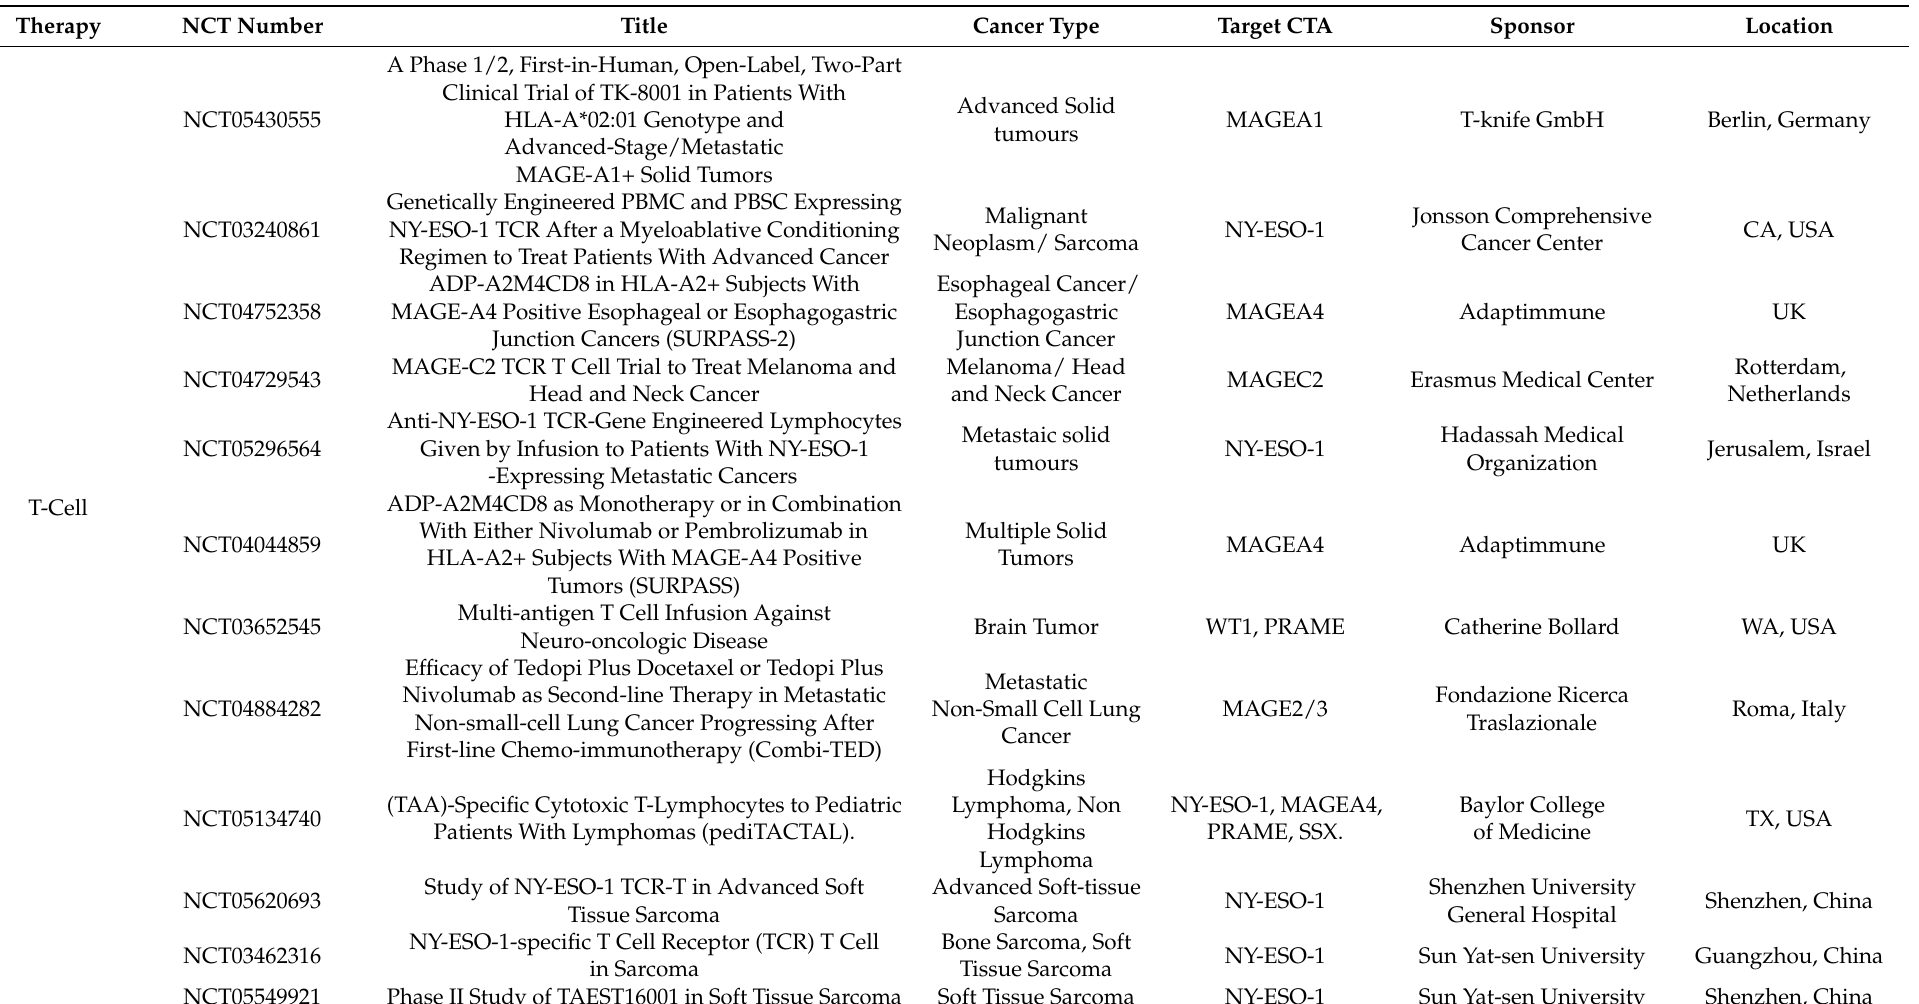
Table 1. List of currently recruiting clinical trials targeting